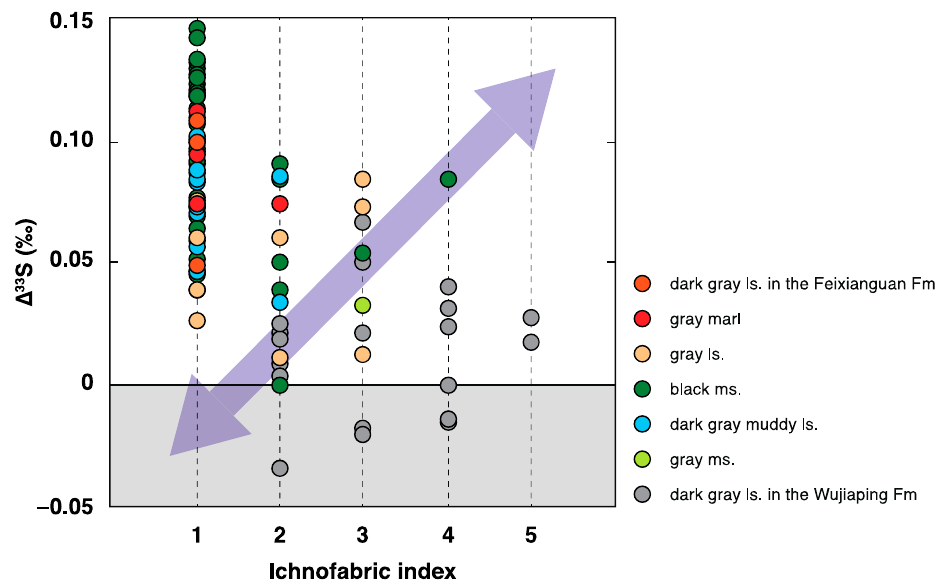
Figure 11. Correlation between ∆ 33 S and ichnofabric index of the P-TB sediments at Chaotian [122]. According to the previous shoaling model [55,67], a positively correlated variation (arrow) would have been observed because the negative ∆ 33 S signal was restricted to anoxic/sulfidic sediments with no burrows. That is not the Chaotian case.